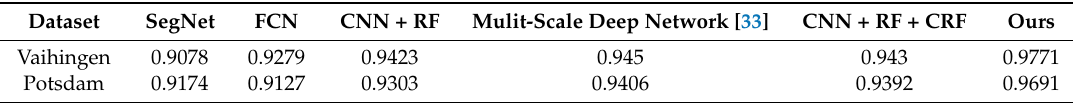
Figure 10. The results of the building extraction in the urban district of the Potsdam dataset with and without the NDVI as a channel of the input. ( a ) The original imagery of the urban district. ( b ) The NDVI of this district. ( c ) The ground of this region. ( d ) The prediction results using the Res-U-Net without the NDVI as a channel of input. ( e ) The prediction results corresponding to the input with the NDVI. Table 3. Compared with the results of proposed method with others methods on Vaihingen and Potsdam datasets.